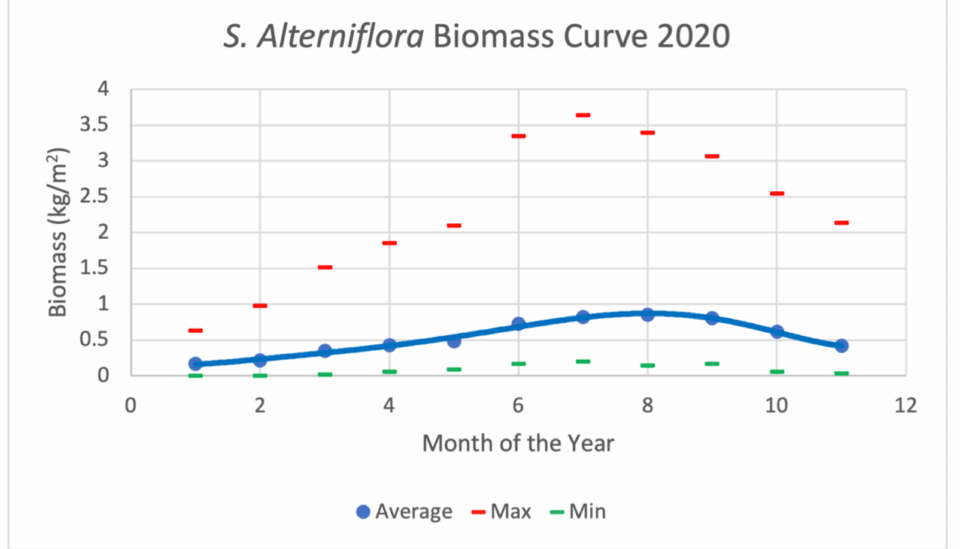
Figure 6. S. alterniflora average biomass curves derived from 29 subplots in NIWB over the year 2020. The peak biomass for each plot varies but ranges from late July to the beginning of